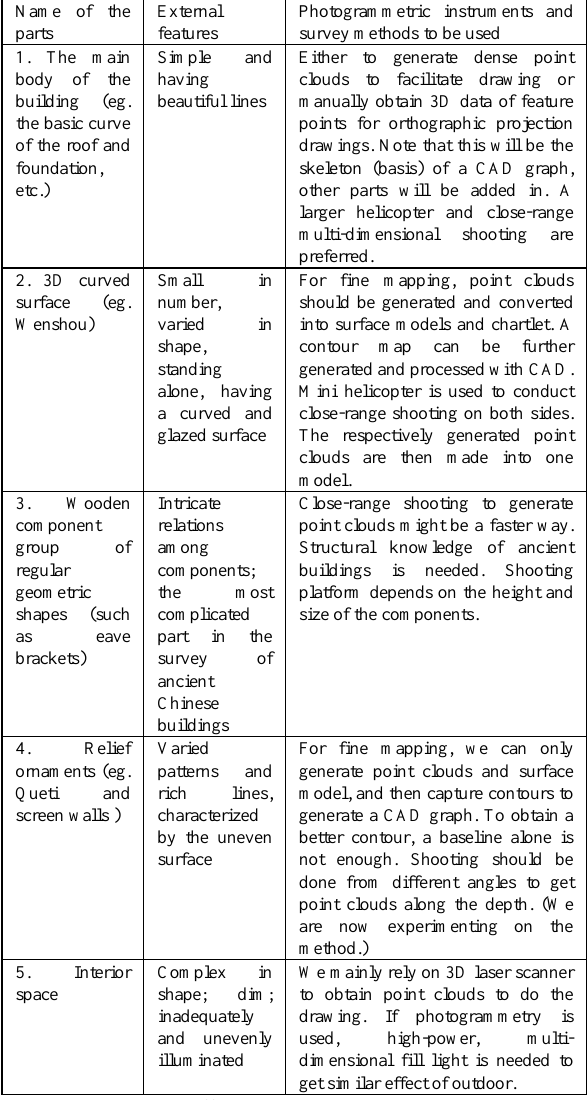
Table 1. Different parts and survey methods